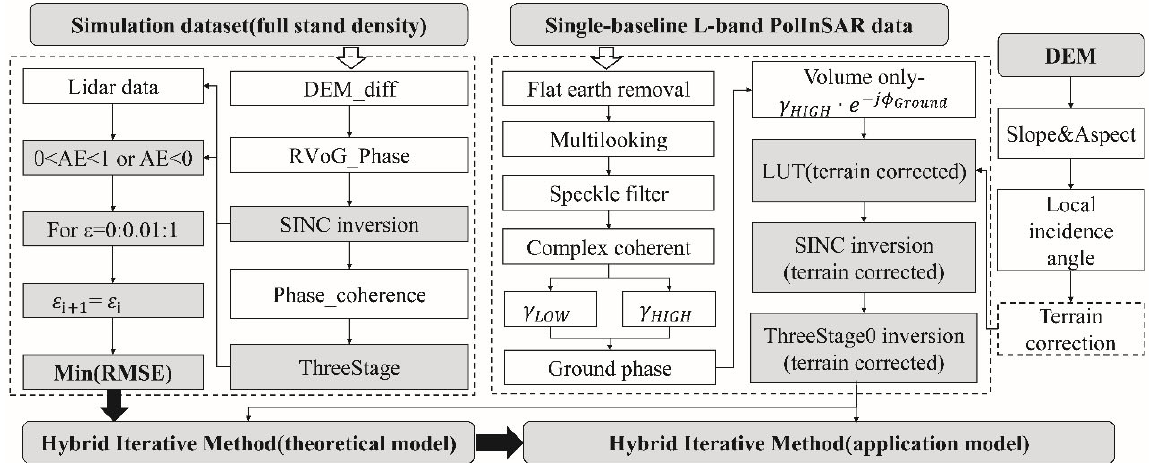
Figure 4. Flow chart. DEM_diff is the DEM difference method, SINC inversion is the SINC inversion method, RVoG_Phase represents the RVoG ground phase method, ThreeStage represents the tradi- tional three-stage inversion method, Phase_Coherence is the phase and coherence inversion method, Hybrid Iterative Method (theoretical model) represents coherence amplitude and three-stage